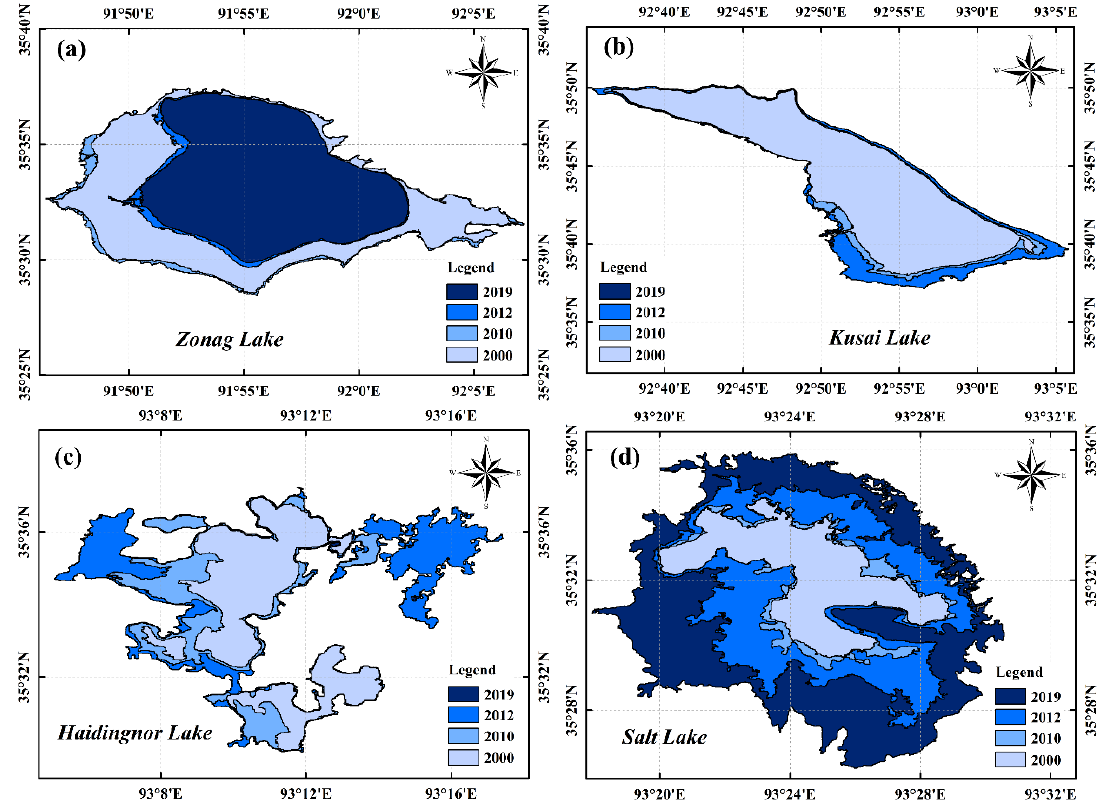
Figure 6. Changes in shorelines in 2000, 2010, 2012 and 2019 of the ( a ) Zoang Lake; ( b ) Kusai Lake; ( c ) Haidingnor Lake and ( d ) Salt Lake.